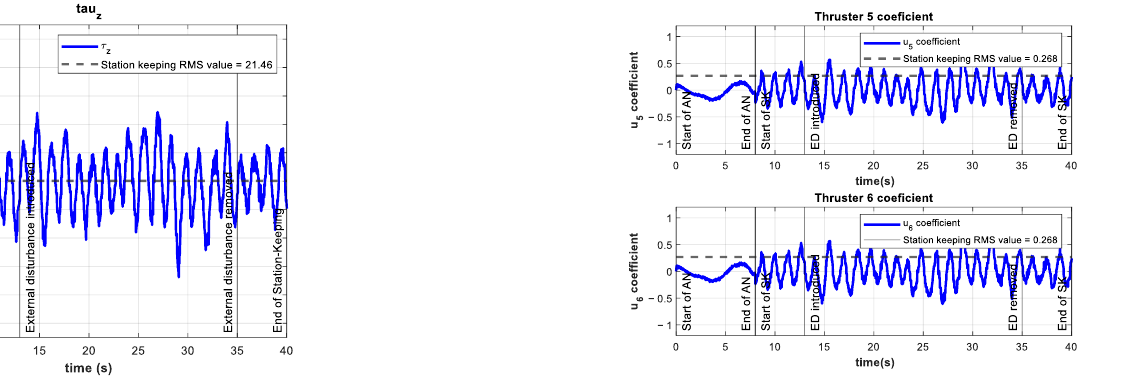
Figure 21. Experimental results for depth station-keeping with a time-varying external disturbance